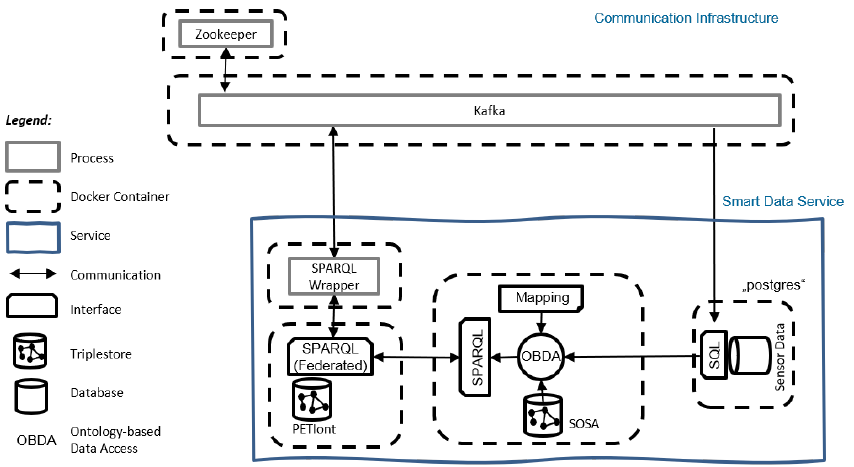
Figure 5. Smart Data Service and Communication